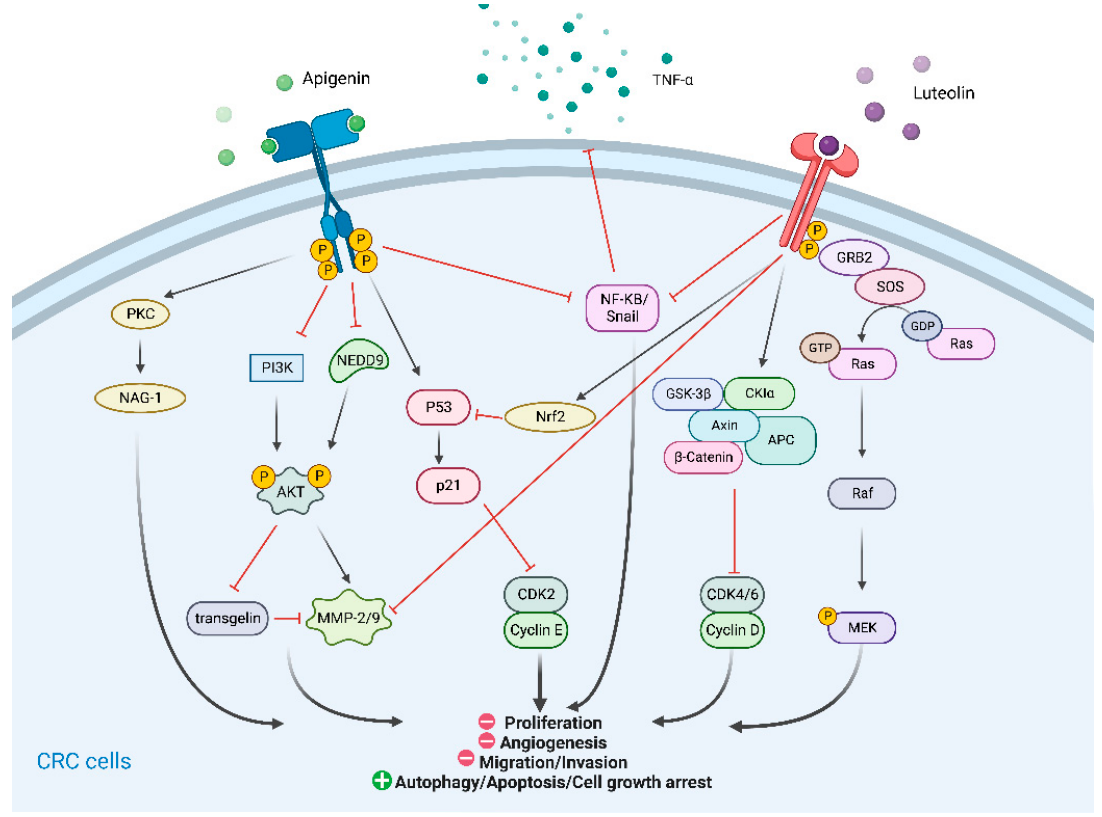
Figure 4. Mechanism of apigenin and luteolin against colorectal cancer cells. Created by Bio ren- der.